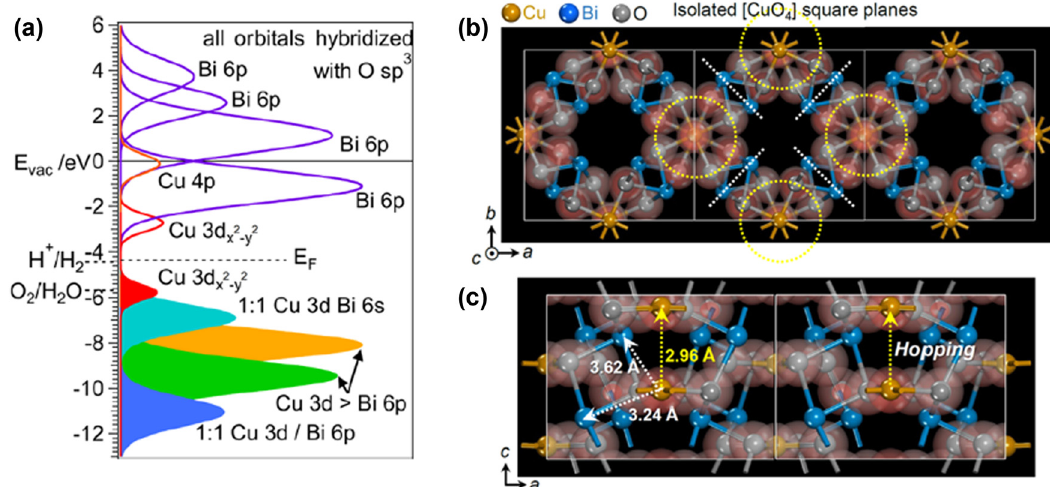
Figure 8: ( a ) Orbital composition of valence and conduction bands of CuBi 2 O 4 , with the H + /H 2 and O 2 /H 2 O redox potentials as reference. ( Reprinted with permission from ref. [ 157 ] . Copyright © 2021, American Chemical Society ) . ( b ) Electron density di ff erence fi eld isosurface contours illustrating lack of overlap of electron density among [ CuO 4 ] 6 ‒ units. ( c ) Electron density isosurface in b - axis projection, showing Cu ‒ Cu and Cu ‒ Bi interatomic distances and most probable direction of polaron hopping. ( b and c reprinted with permission from ref. [ 158 ]